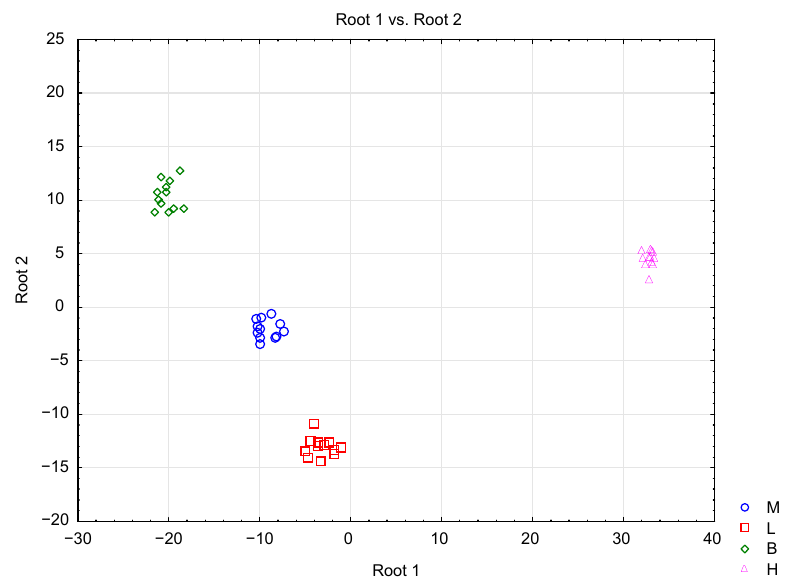
Figure 3. Scatterplot of canonical discriminant scores for analyzed types of honey: M—multifloral honey, L—lime honey, B—buckwheat honey, H—honeydew honey using LDA.